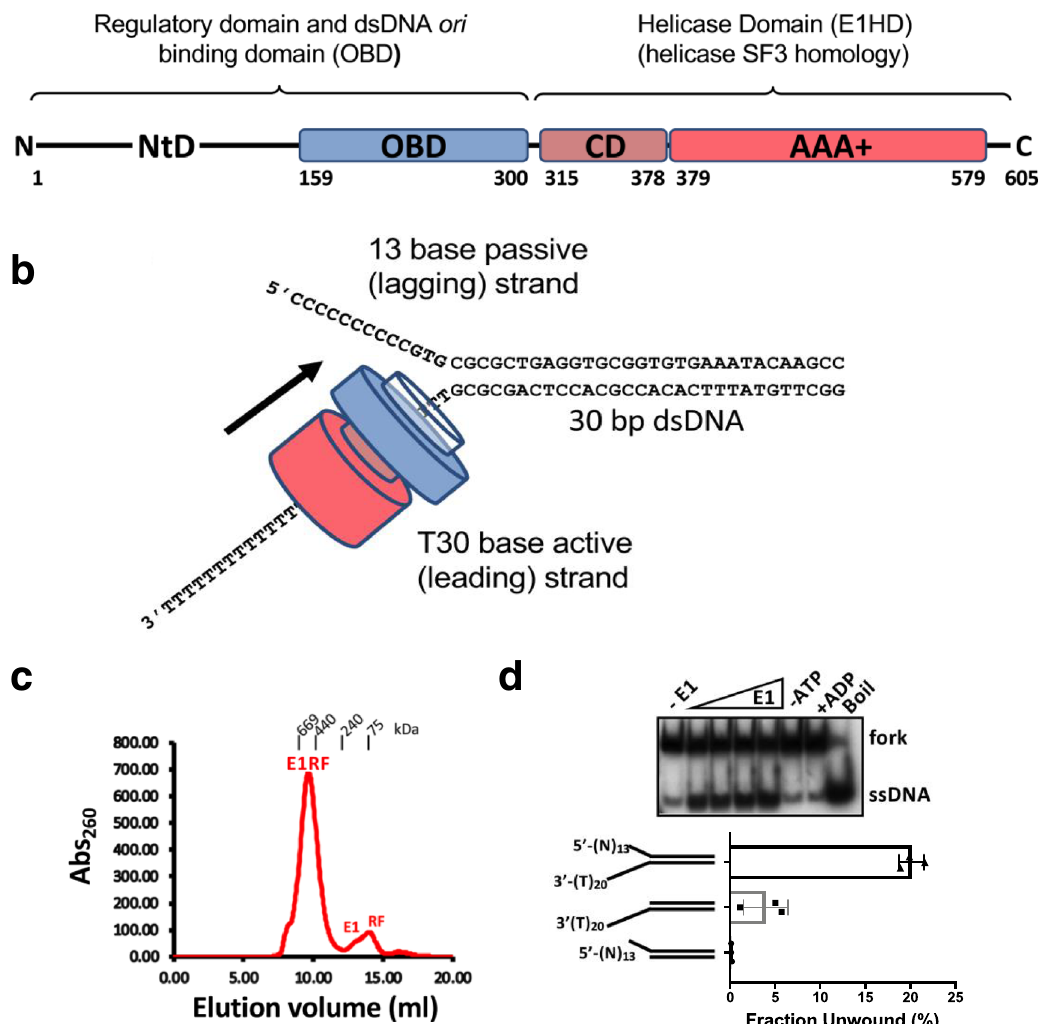
Fig. 1 The E1RF helicase complex. a Domain organisation of Bovine Papillomavirus (BPV) E1. b A schematic representation of the E1RF complex on the fork sequence used. c A homogenous fraction of the E1RF complex puri fi ed by gel fi ltration was used for cryo-EM. The calibration markers are thyroglobulin, 669 kDa, ferritin, 440 kDa, catalase 240 kDa and conalbumin, 75 kDa. d The unwinding activity of the E1 protein (50, 100, 200 and 400nM E1) on the replication fork substrate used to generate E1RF and comparison with substrates without 5 ′ or 3 ′ ssDNA tails (100 nM E1, n = 3 independent experiments; shown mean values with error bars ±